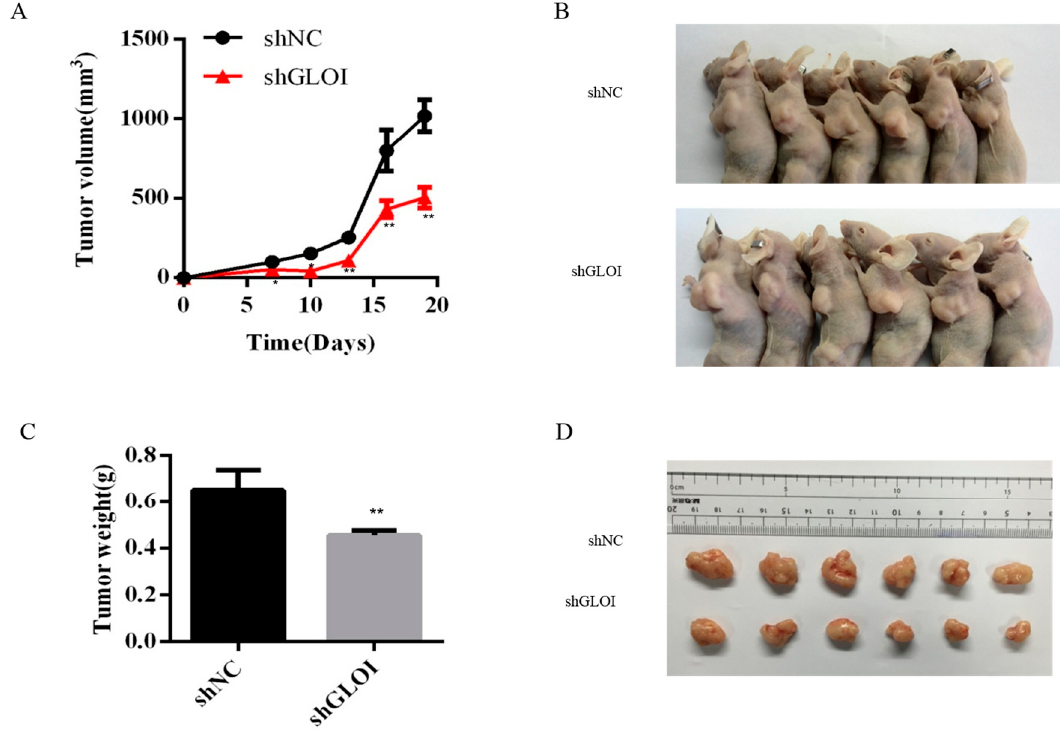
Figure 9. GLOI knockdown reduces SW620 xenograft tumor growth in BALB/c nude mice (6 mice/group). Mice were injected subcutaneously with SW620 colorectal cancer cells transfected with shGLOI or shNC and monitored for SW620 tumor growth beginning on day 7 after injection. Tumors were measured every 3 days from that day. ( A ) Changes in tumor volume over time were plotted. ( B ) The tumor-bearing mice were killed on day 19 and their tumors dissected. ( C ) The weight of each dissected tumor was measured at the time of the animal’s death. All data are representative of three independent experiments ( n = 6). ( D ) The dissected tumors are shown. ** p < 0.01.